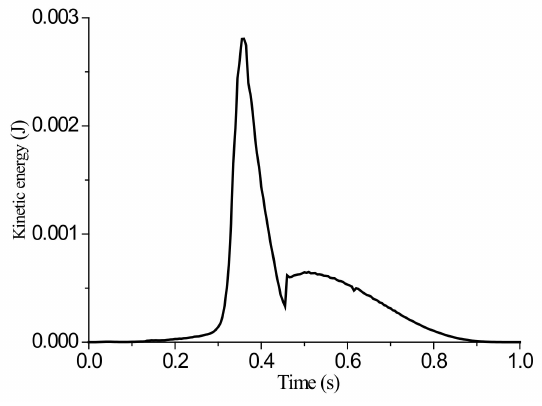
Figure 8. Variation of kinetic energy with time.